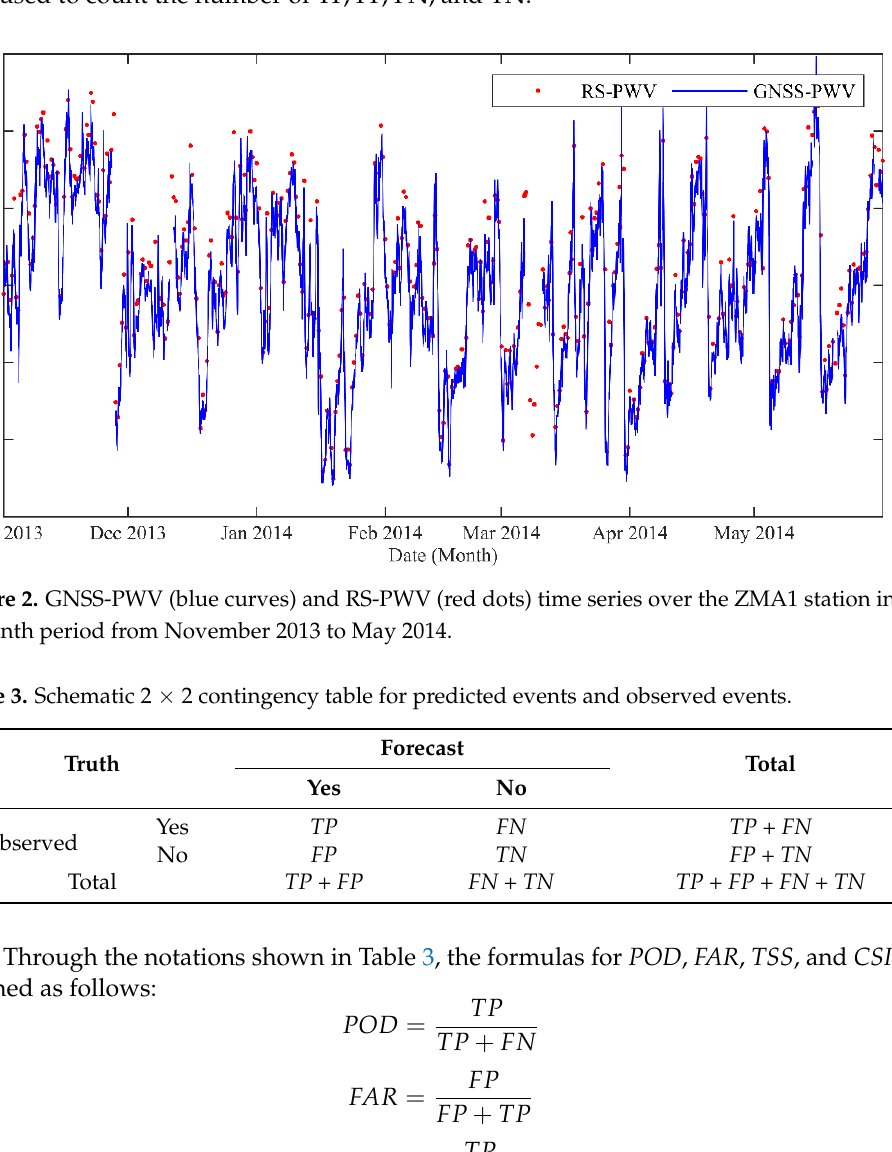
Table 3. Schematic 2 × 2 contingency table for predicted events and observed events. Truth